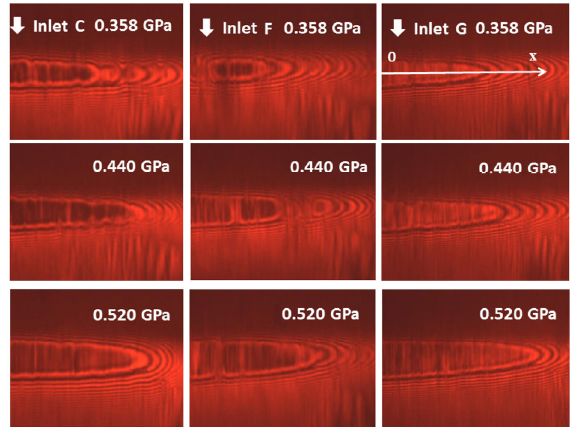
Fig. 15 Interference images of three types of grease under different loads ( u = 15 mm/s, straight line profile).